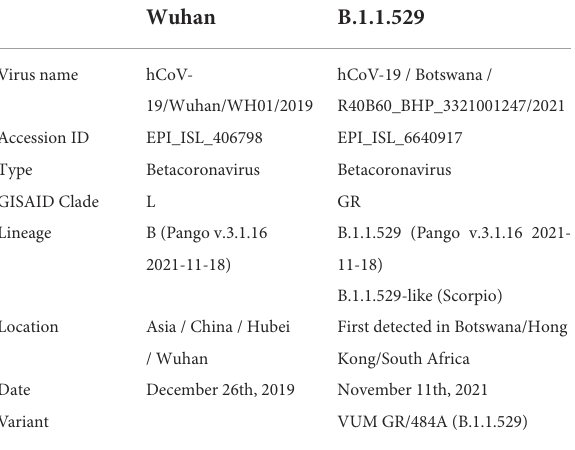
TABLE 1 Details of the two SARS-CoV-2